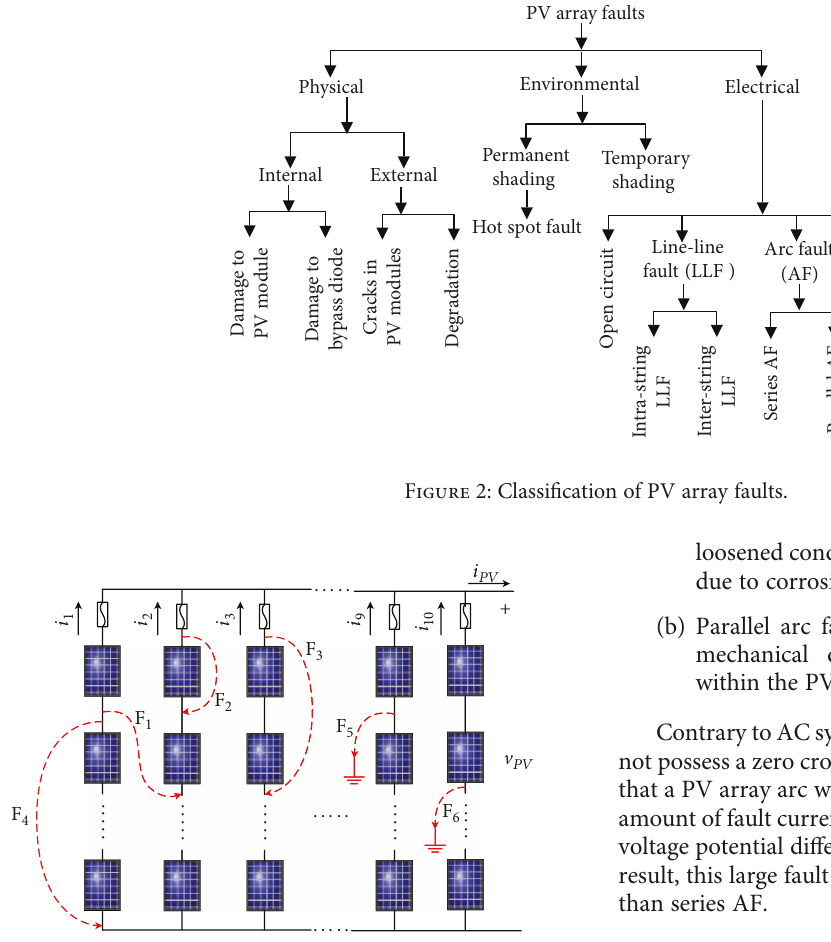
Figure 3: PV array con fi guration showing possible line-to-line faults and ground